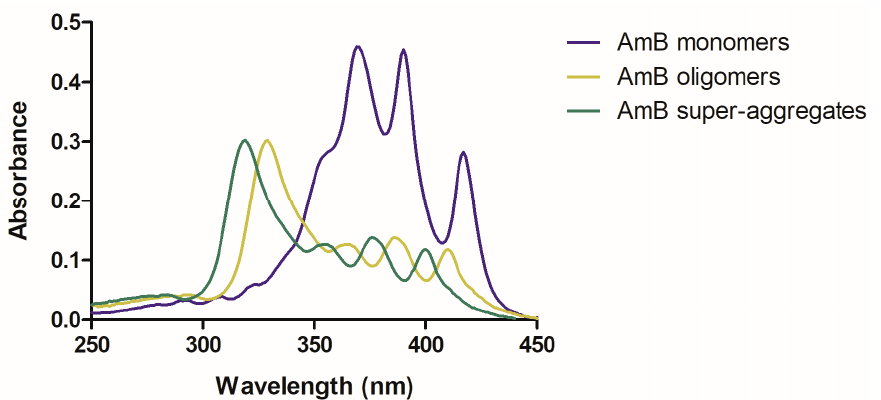
Figure 2. Representative UV/Vis spectra of the different AmB supramolecular forms: monomer (in blue), oligomers (in moss green) and aggregates (in green).